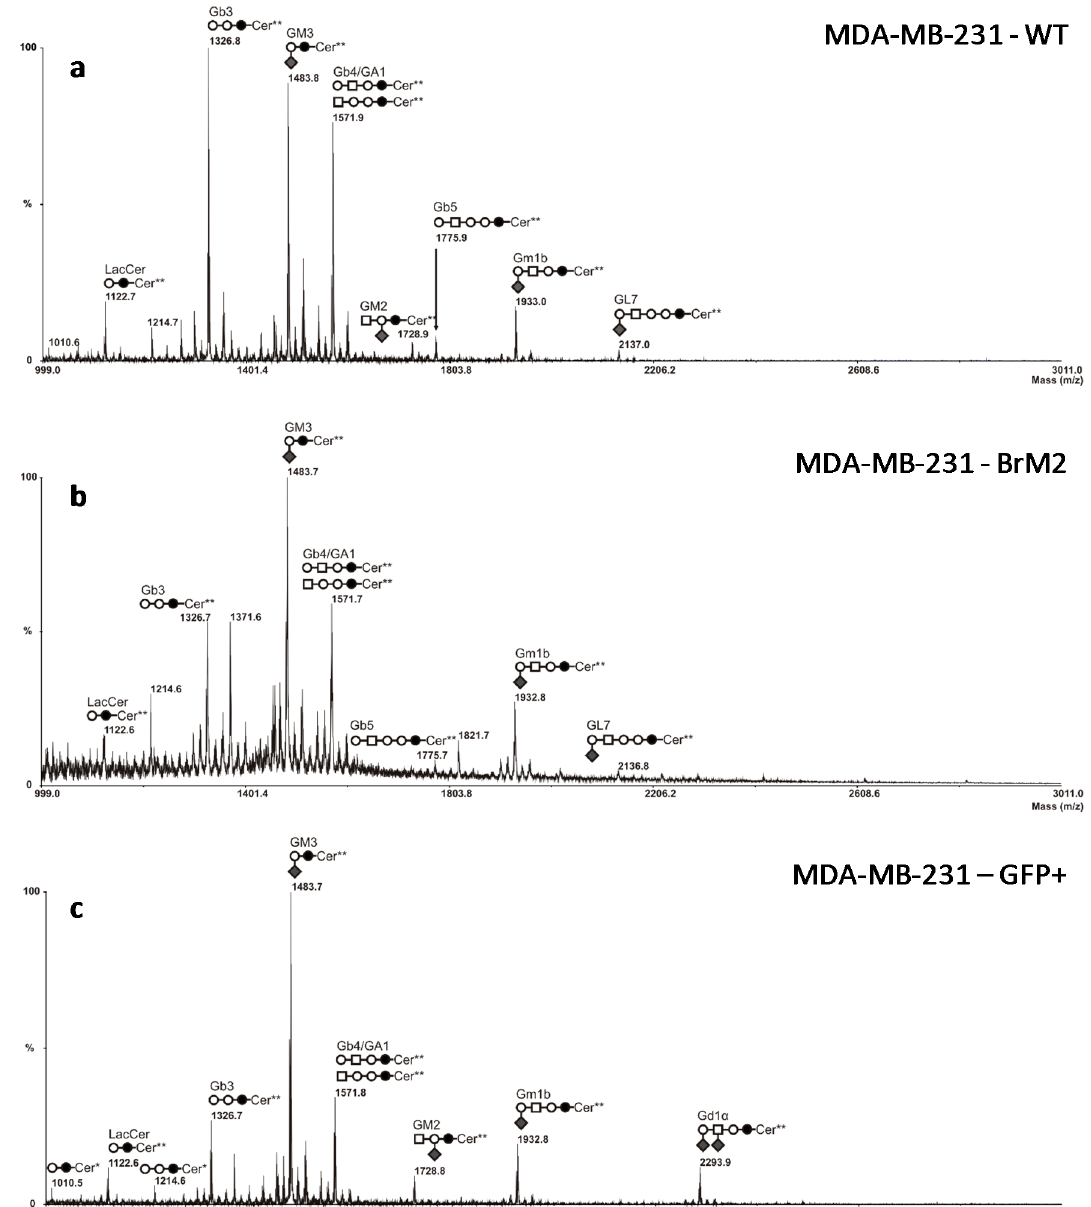
Figure 3. Comparison of mass spectrometry (MS) profiles of permethylated glycosphingolipids purified from MDA-MB-231 wt ( a ); BrM2 ( b ); and green fluorescent protein positive (GFP+) ( c ) cell population. Glycosphingolipids (GSL) are present as d18:1/C16:0 (Cer*) and d18:1/C24:0 (Cer**) isomers.